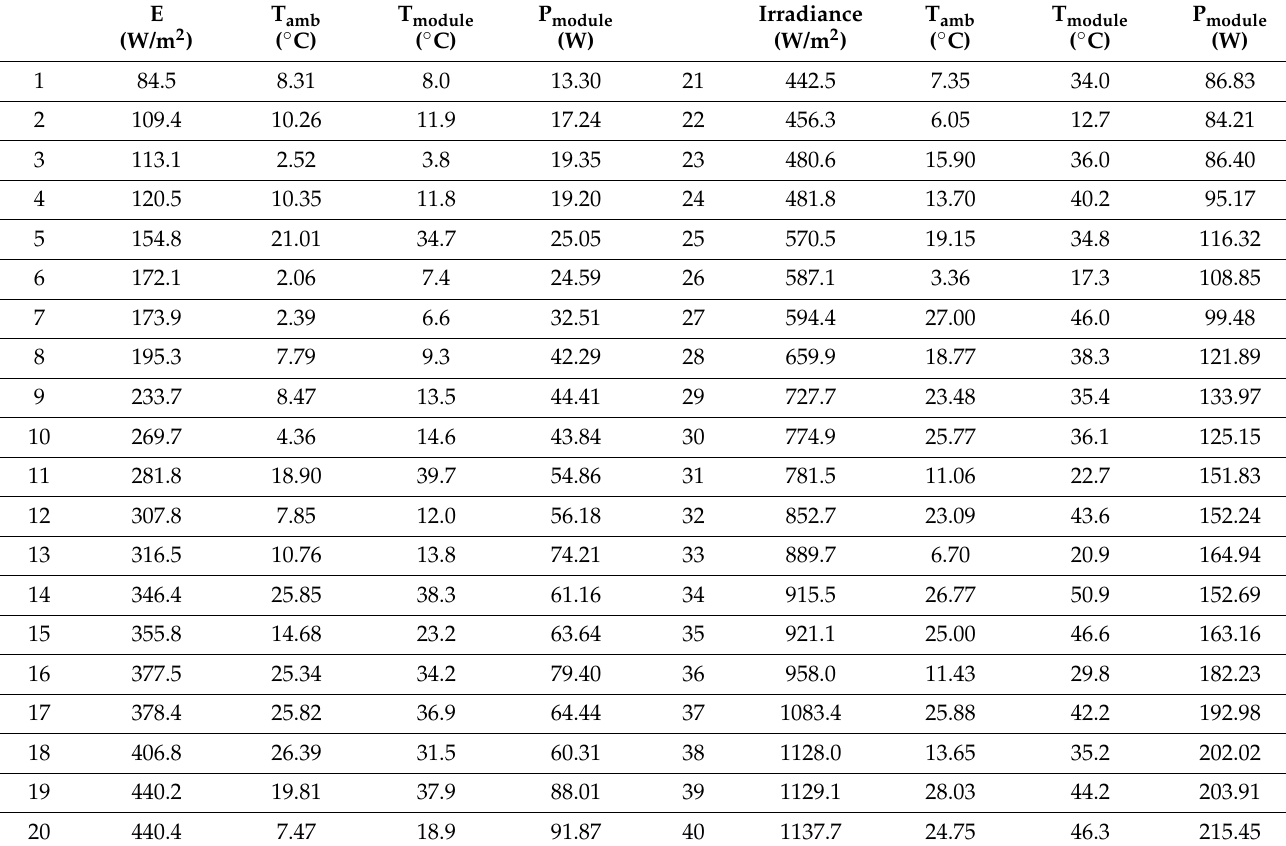
Table 4. Variability of recorded parameters for a wide range of measured irradiance.